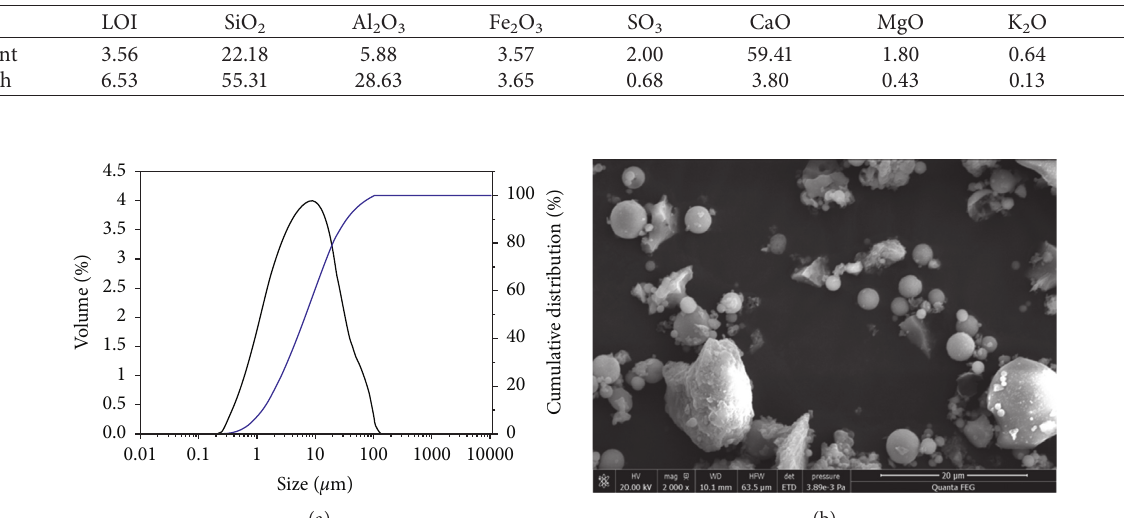
Figure 1: (a) Particle size distribution and (b) SEM image of FA.